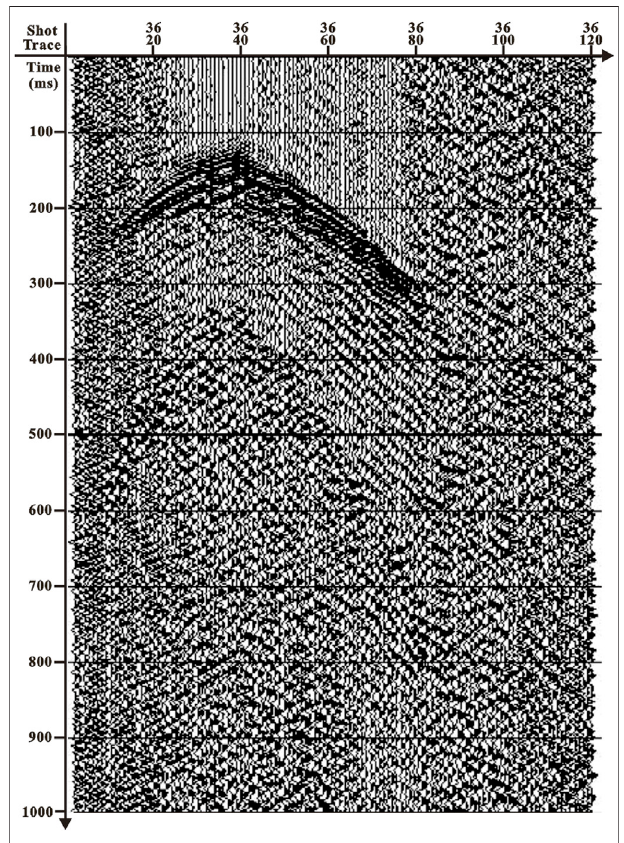
FIGURE 10 | Wave fi eld records of crosswell seismic.